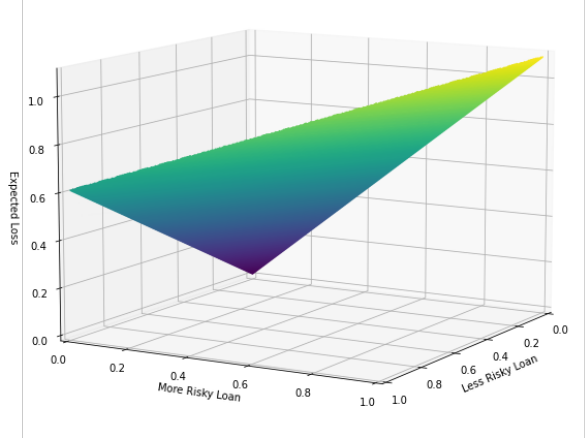
Figure 2. Expected Loss against investments in risky loans.